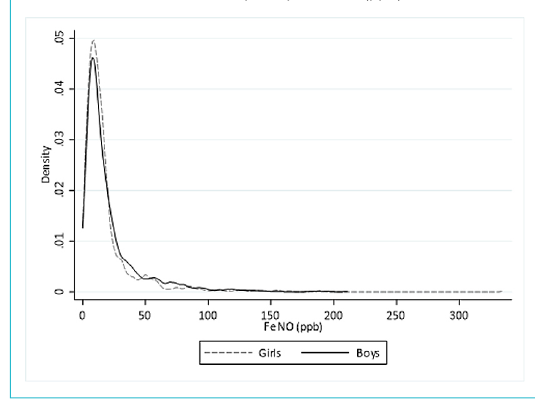
Figure 6: Distribution of fractional exhaled nitric oxide (FeNO) by sex in children from the LuftiBus in the School (LUIS) study at baseline. FeNO measured in parts per billion